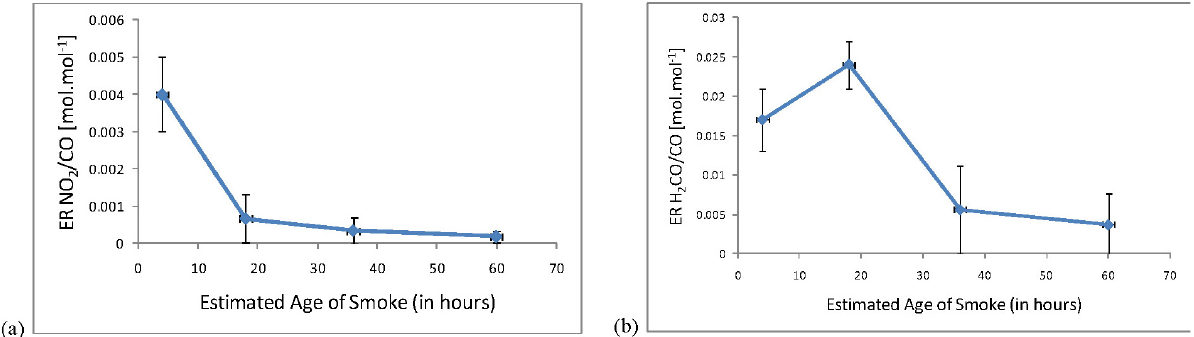
Figure 5. Normalized excess mixing ratios with respect to CO for ( a ) NO plotted as a time-series as the smoke ages from the youngest smoke measured over the active fire area on 8 February 2009 (~4 hours old) to the oldest smoke measured to the north of New Zealand on 10 February 2009 (~60 hours